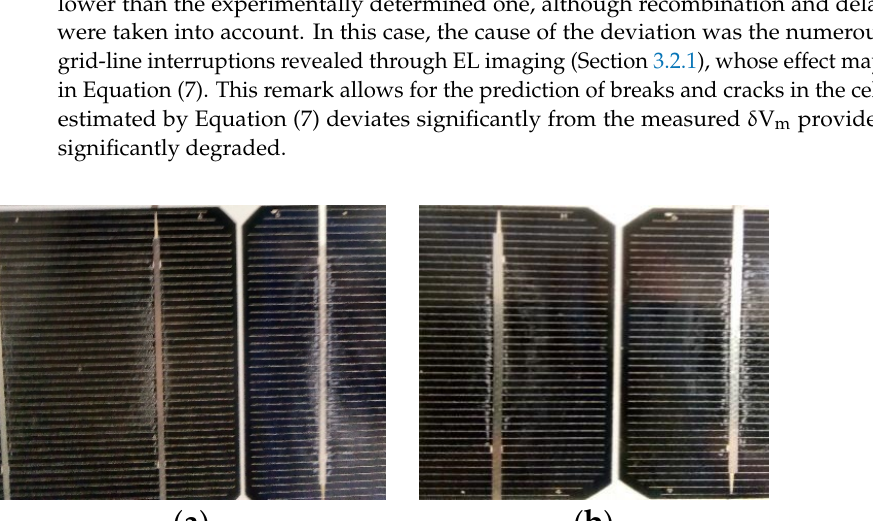
Figure 10. ( a , b ) Digital image of SM55 module no3 with extended EVA delamination in the busbar areas.